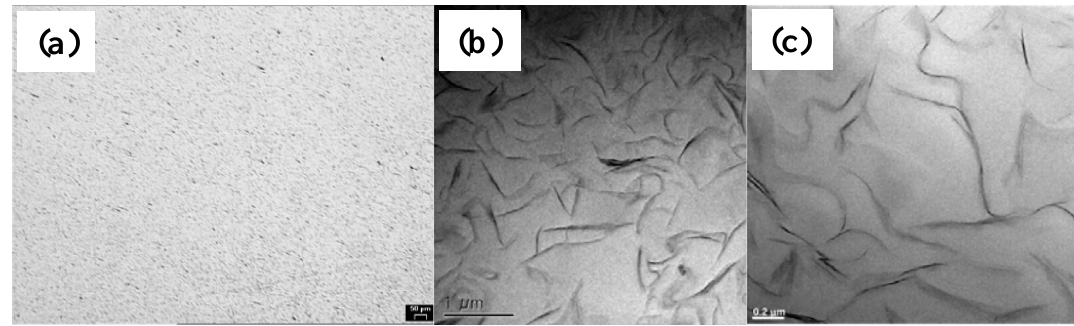
Figure 5. Micrographs of Epoxy/S-clay 2.5: (a) Optical micrographs of polished surface; (b) and (c) TEM micrographs (adapted from